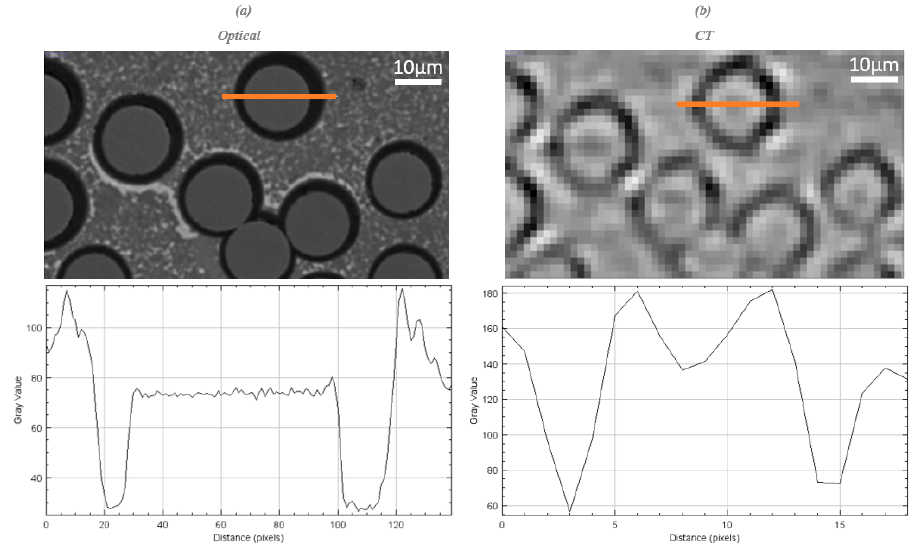
Figure 2. ( a ) Optical, ( b ) CT. Higher magnification images of an area from Figure 1a, with grey level profiles along lines indicated. Pixel sizes: 0.17 µm/pixel in optical image; 1.3 µm/pixel in CT image. The optical image reveals that BN coatings around the fibers have a variable thickness between 0.2 and 4 µ m (varying both around a given fiber and between different fibers), whereas the lower-resolution CT images show no clear difference in widths of thick